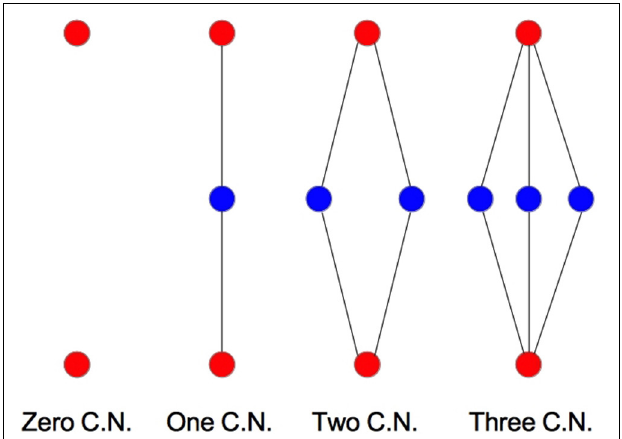
FIGURE 2 | Common neighbor clustering illustrated. Tested nodes are red; common neighbors are blue.